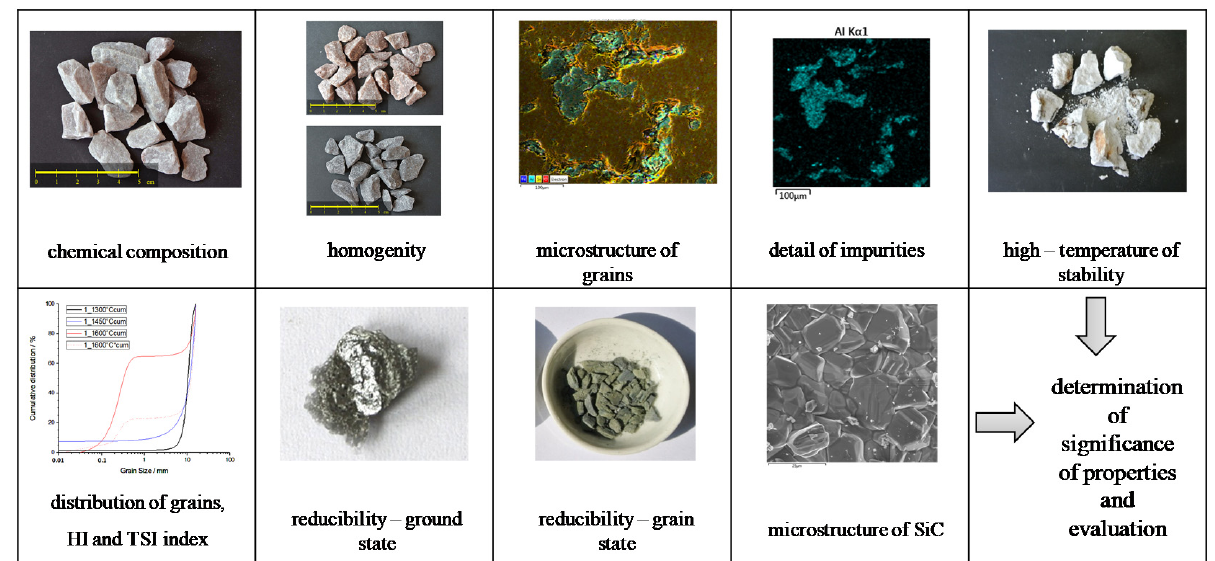
Figure 2. Methods for the evaluation of quartzes or quartzites.